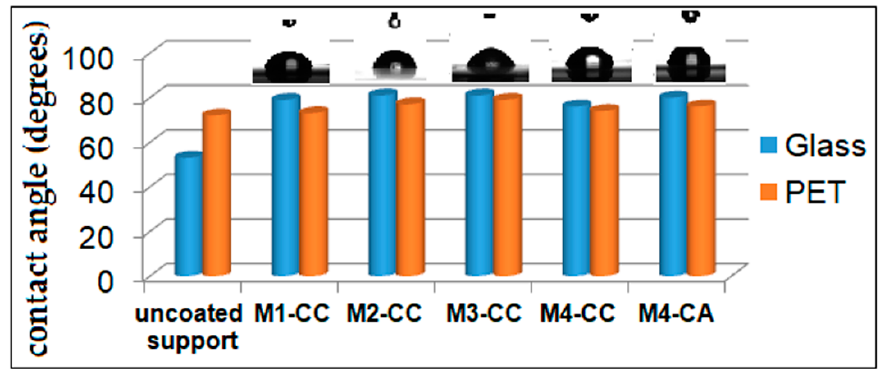
Figure 6. The contact angle of hybrid coatings depends on the coated support.